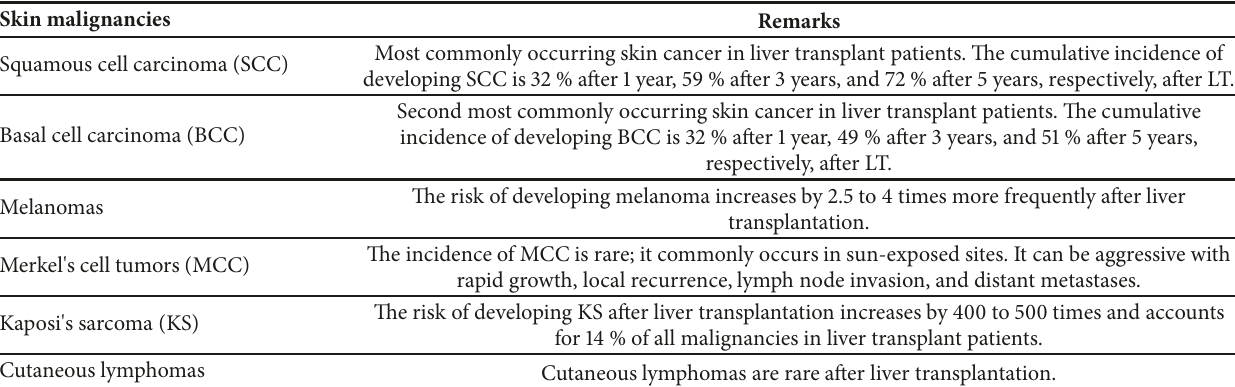
Table 5: Skin malignancies in liver transplant